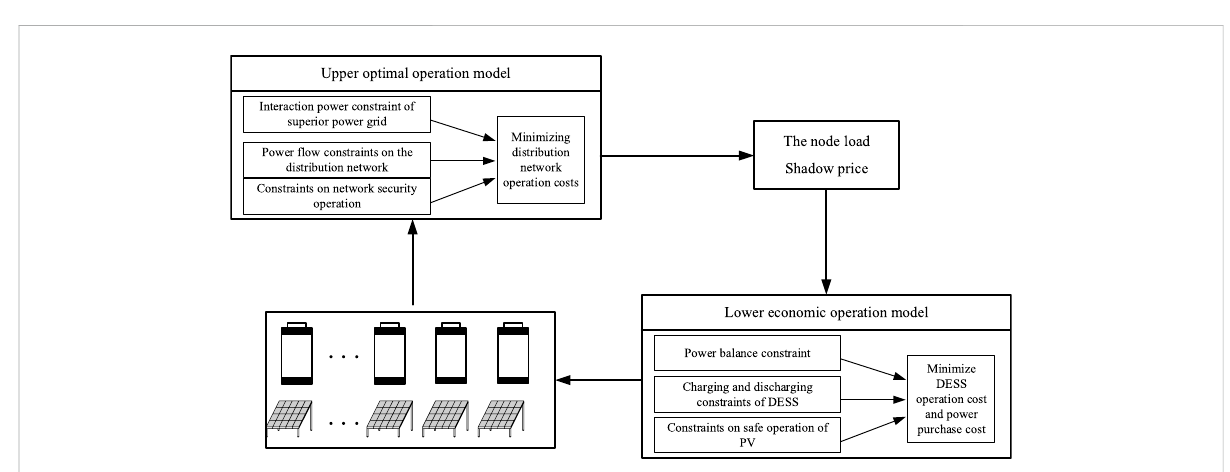
FIGURE 2 Radial distribution network structure and hierarchical dispatching